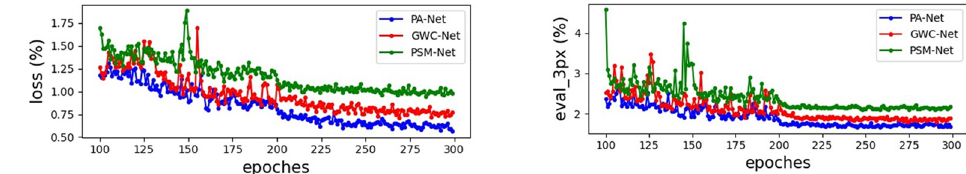
Fig 6. Training curves of PA-Net, GWC-Net and PSM-Net on KITTI 2015 dataset from epoch 100 to 300. PA-Net exhibits improved optimization characteristics and more stabled in training.